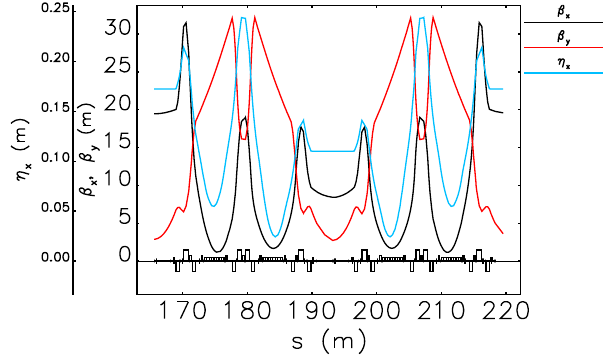
FIG. 33. Reduced lattice functions at the HSCU location. Two sectors are shown. Middle of the plot shows the HSCU location, while the left and right sides of the plot show the standard APS ID straight